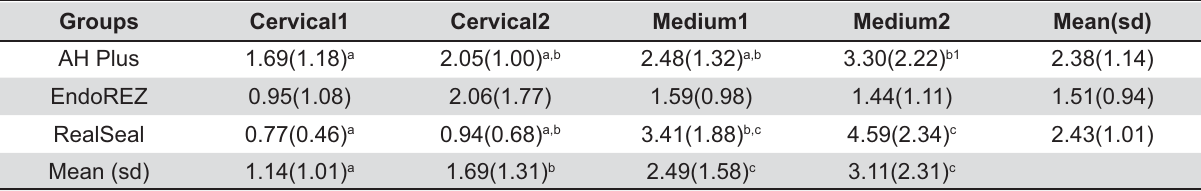
Table 2- (cid:12) %(cid:3)(cid:6)(cid:23)(cid:24)(cid:12) (cid:6)(cid:23)(cid:25)(cid:12) (cid:24)(cid:10)(cid:6)(cid:23)(cid:25)(cid:6)(cid:4)(cid:25)(cid:12) (cid:13)%(cid:30)(cid:6)(cid:20)(cid:12) (cid:25)(cid:3)#(cid:8)(cid:6)(cid:10)(cid:8)"(cid:23)(cid:24)(cid:12) "(cid:22)(cid:12) (cid:14)(cid:30)(cid:31)(cid:24)(cid:19)!"(cid:31)(cid:10)(cid:12) (cid:7)"(cid:23)(cid:25)(cid:12) (cid:24)(cid:10)(cid:4)(cid:3)(cid:23)(cid:27)(cid:10)(cid:19)(cid:12) (cid:10)(cid:3)(cid:24)(cid:10)&(cid:12) (cid:21)(cid:8)(cid:22)(cid:22)(cid:3)(cid:4)(cid:3)(cid:23)(cid:10)(cid:12) (cid:9)(cid:3)(cid:10)(cid:10)(cid:3)(cid:4)(cid:24)(cid:12) (cid:8)(cid:23)(cid:25)(cid:8)(cid:26)(cid:6)(cid:10)(cid:3)(cid:12) (cid:24)(cid:8)(cid:27)(cid:23)(cid:8)(cid:28)(cid:26)(cid:6)(cid:23)(cid:10)(cid:12) differences in μPush-out strength values among root levels, for each material and for the whole sample